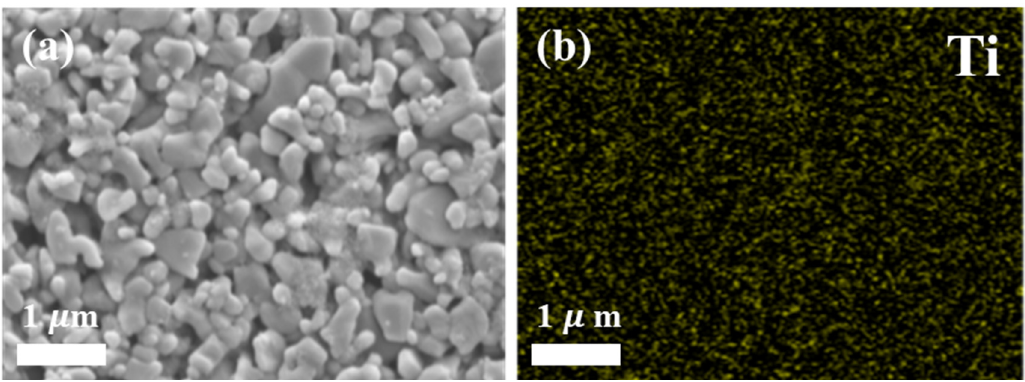
Figure 3. ( a ) Surface SEM image and ( b ) the corresponding EDS elemental (Ti) mapping image of POEM ‐ directed TiO 2 films on Al 2 O 3 membrane.